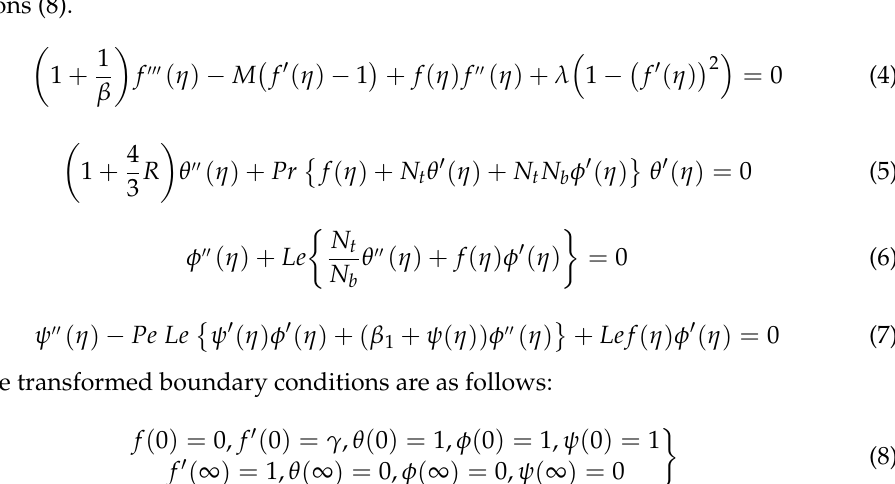
Figure 1. Physical con fi guration of Falkner–Skan fl ow model.